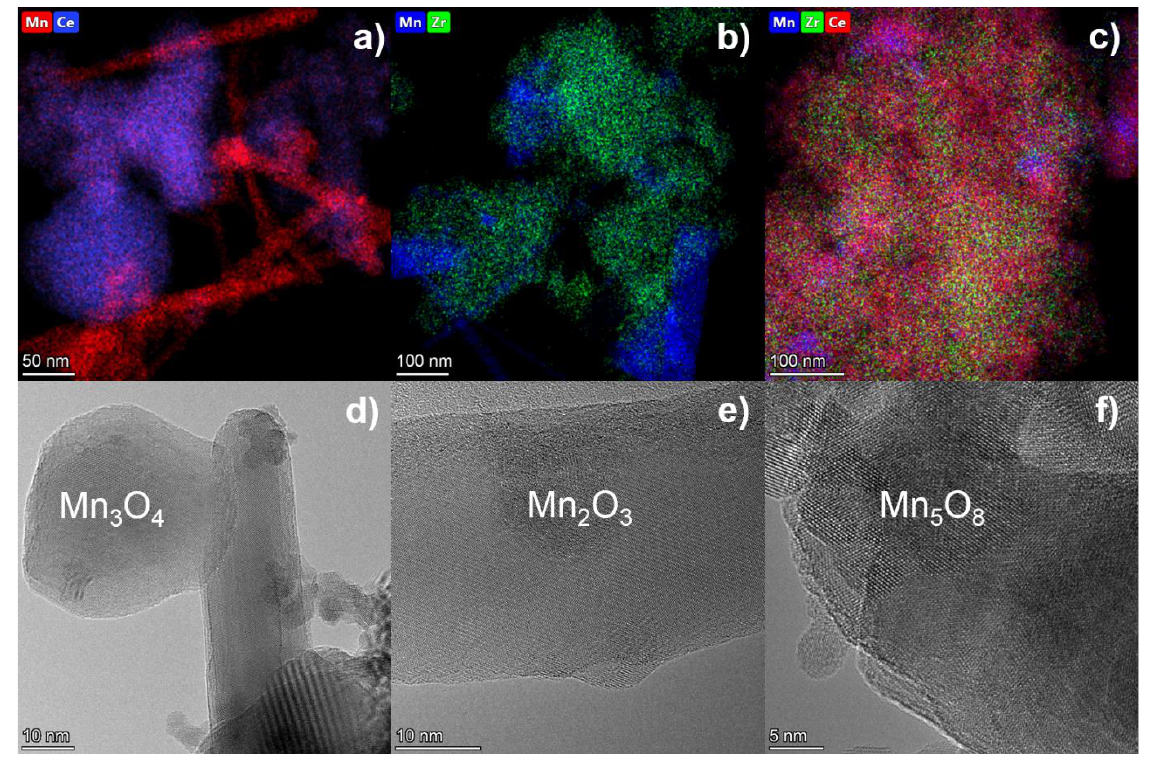
Figure 3. ( a – c ) TEM image; ( d – f ) EDS mapping pattern for ( a , d ) Mn-Ce-500, ( d , e ) Mn-Zr-700 and ( c , f ) Mn-Zr-Ce-600 catalysts.